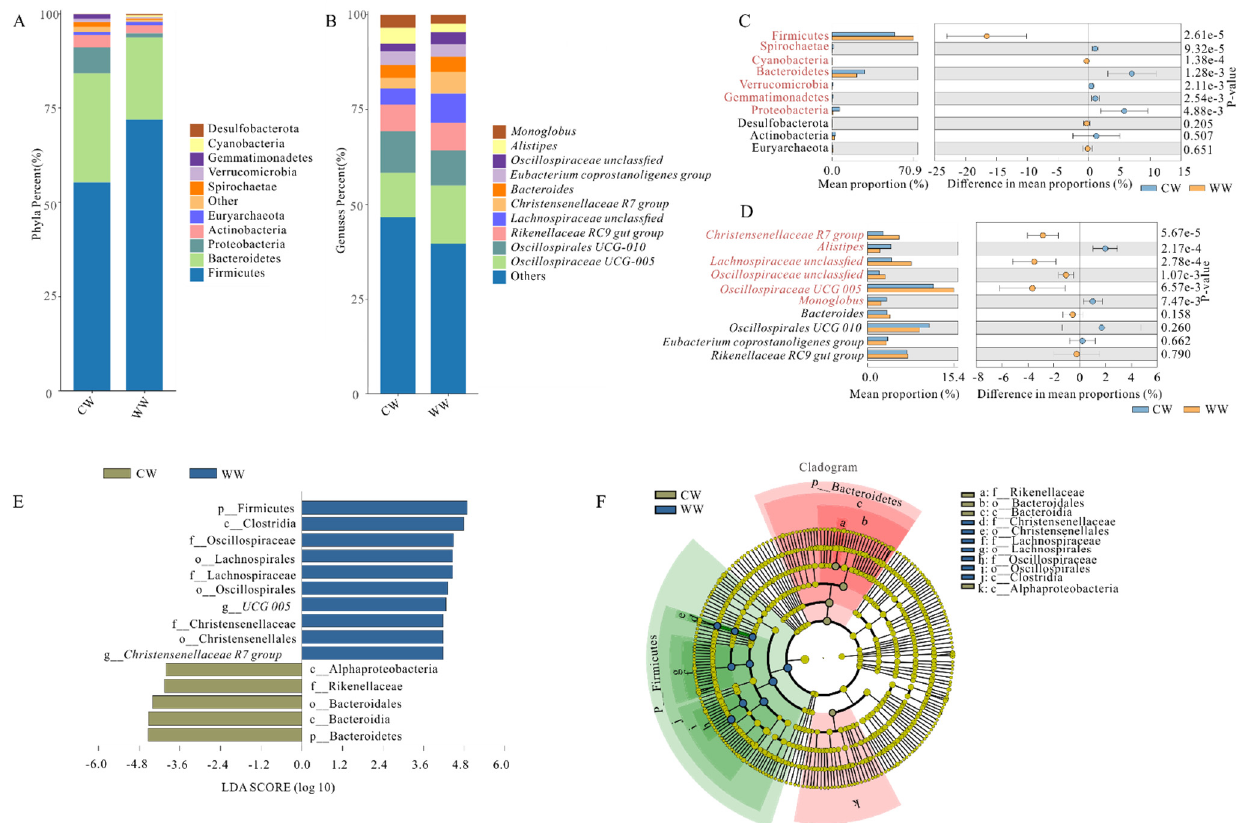
Figure 2. Microbiota composition of fecal samples and component difference analysis. ( A , B ) Bar charts show abundance of top 10 phyla and genera, respectively, between CW and WW. ( C , D ) Sig- nificant differences between the two groups at phylum and genus level, respectively, indicted in red ( p < 0.05). ( E ) Result of LDA effect size determining biomarkers with statistically significant differ- ences between groups. LDA value distribution histogram shows biomarker with statistical differ- ences, and extent of histogram reflects degree of effect (LDA score). ( F ) Each small circle of clado- gram at different levels represents a different classification; diameter is in direct proportion to rela- tive abundance.